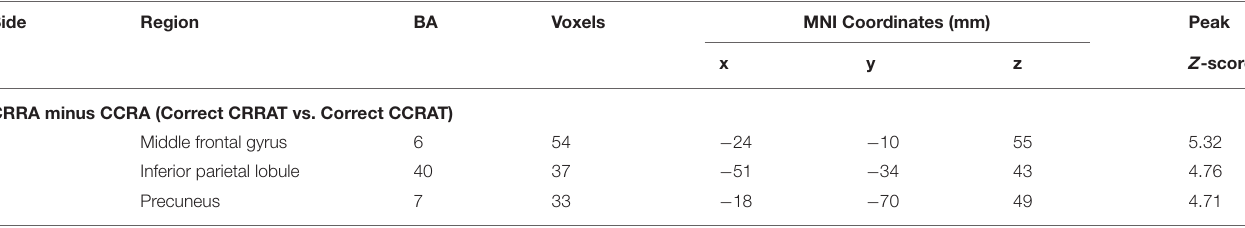
TABLE 3 | Significant brain regions for the difference among remote associations. Side Region BA Voxels MNI Coordinates (mm) Peak x y z Z -score CRRA minus CCRA (Correct CRRAT vs. Correct CCRAT) L Middle frontal gyrus 6 54 − 24 − 10 55 5.32 L Inferior parietal lobule 40 37 − 51 − 34 43 4.76 L Precuneus 7 33 − 18 − 70 49